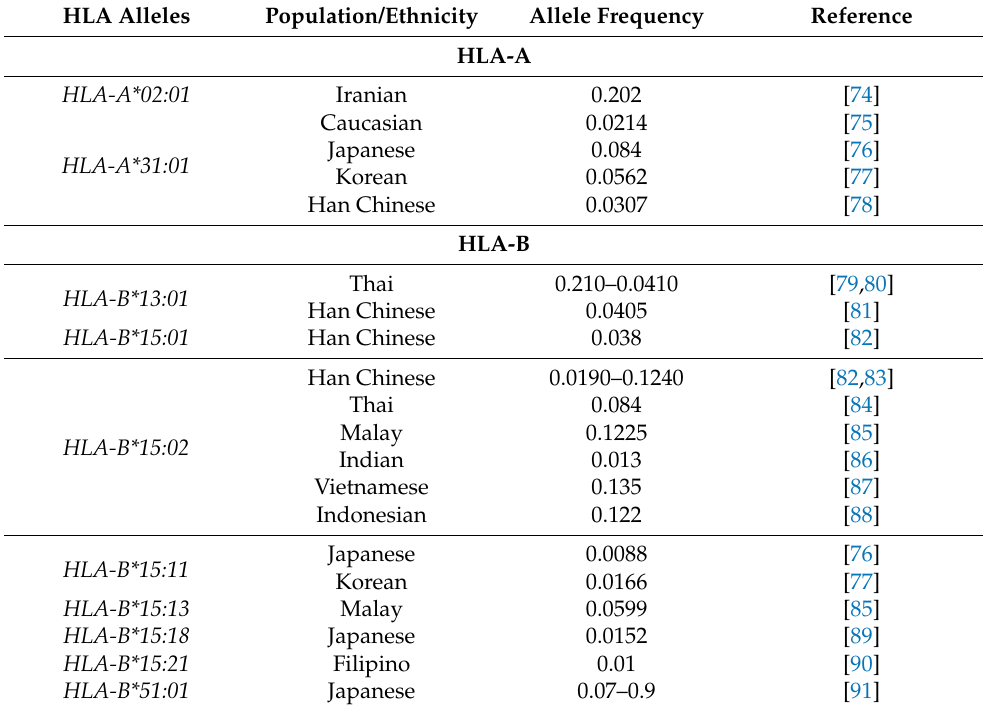
Table 2. HLA-A and HLA-B allele frequency for various